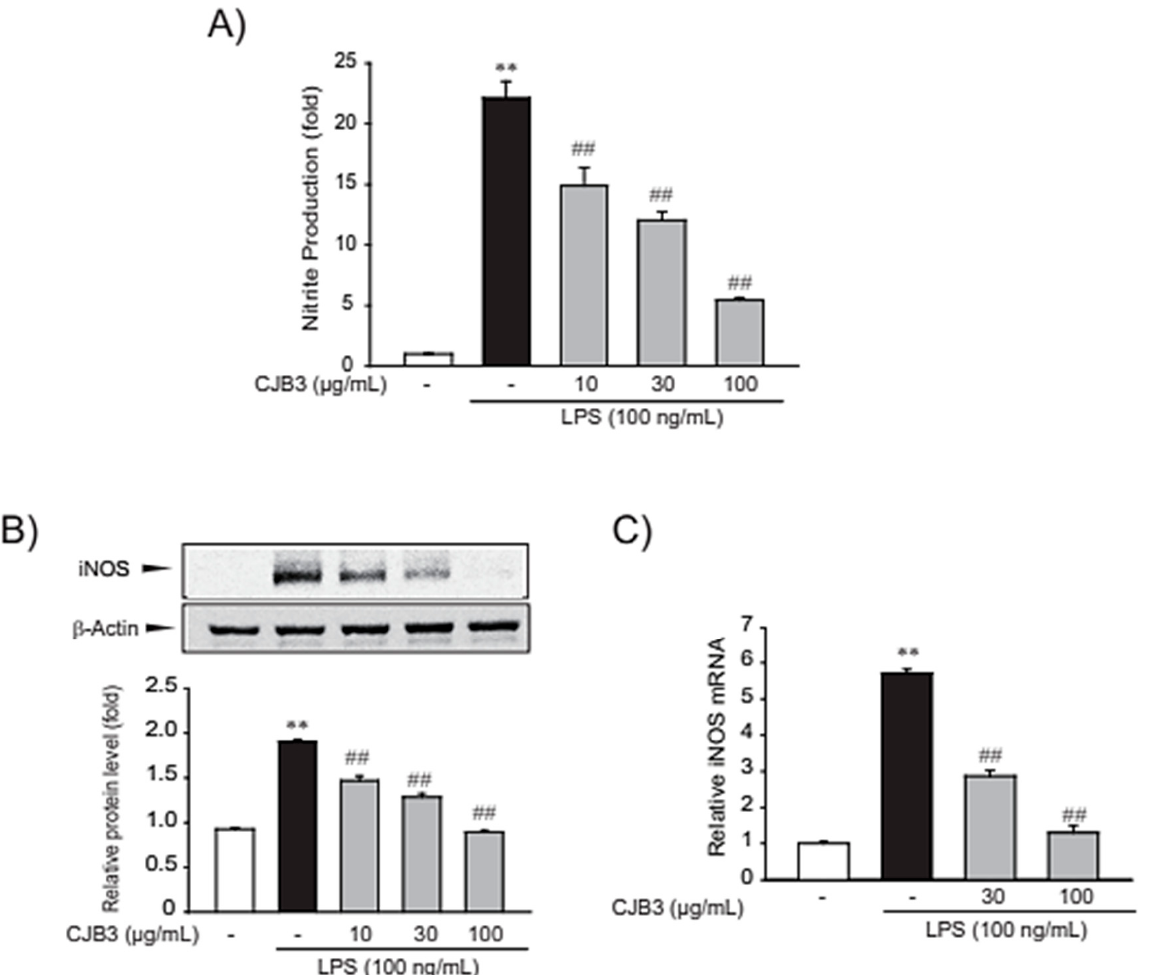
Figure 5. CJB3-mediated inhibition of LPS-induced NO production and iNOS expression. ( A ) Nitric oxide (NO) production: cells were treated with CJB3 (10–100 µ g/mL) and/or LPS for 15 h, and NO production was measured using a Griess reagent. ( B ) CJB3-mediated inhibition of inducible NO synthase (iNOS) expression in LPS-activated RAW264.7 cells: cells were pretreated with varying concentrations of CJB3 (10–100 µ g/mL) for 1 h and incubated with LPS (100 ng/mL) for 12 h. iNOS protein levels in the cell lysates were measured using western blot. ( C ) The iNOS transcripts were analyzed using RT-PCR assays: cells were pretreated with 30–100 µ g/mL CJB3 for 1 h and incubated with 100 ng/mL LPS for 6 h. Data are expressed as the mean ± SE of three replicates; ** p < 0.01., significant vs. vehicle-treated control; ## p < 0.01, significant vs. LPS alone.